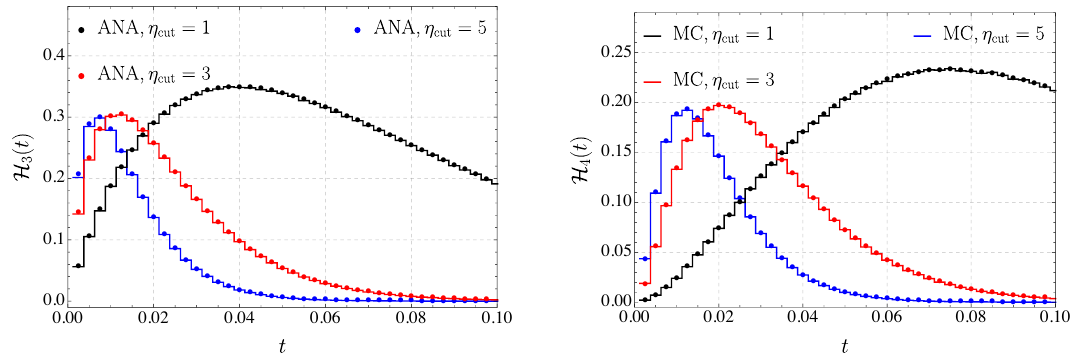
Figure 12 . Numerical comparison between MC simulations and analytical calculations. The histograms represent MC simulations with di(cid:11)erent collinear cuto(cid:11)s (cid:17) cut = 1 (black), 3 (red) and 5 (blue). The dots are from numerically integrating their analytical